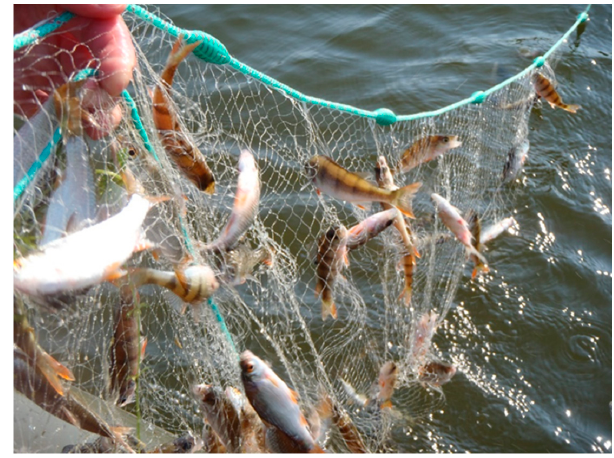
Figure 6. Nets during picking (photo: Konrad Wrzecionkowski).